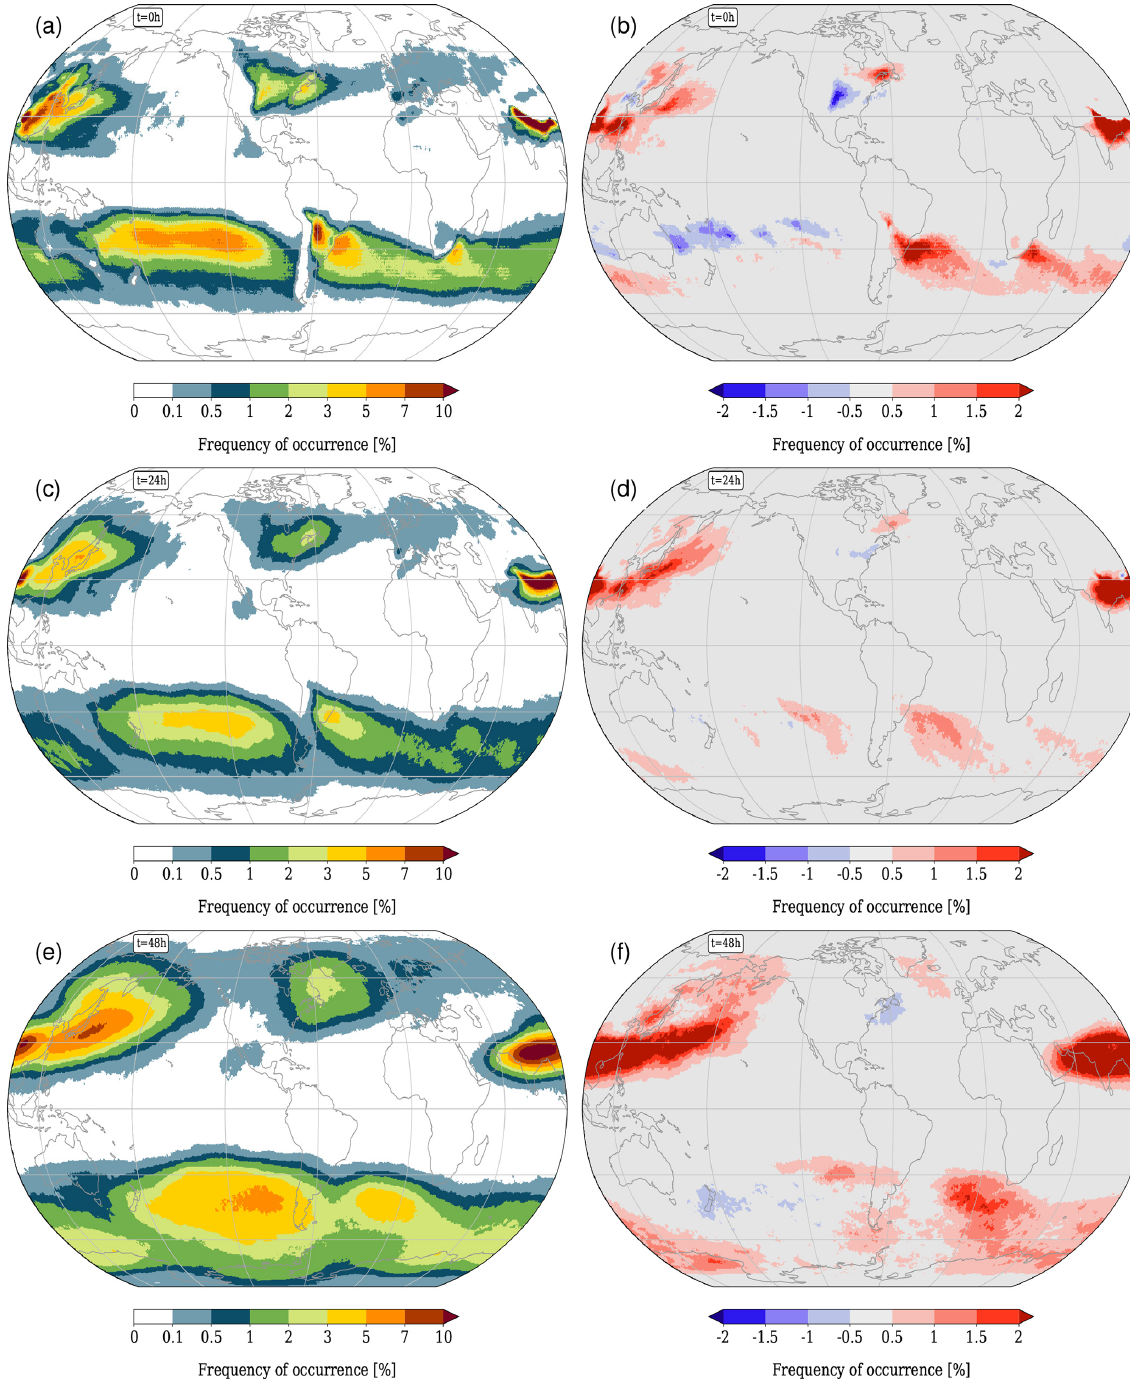
Figure 5. Same as Fig. 4 but for